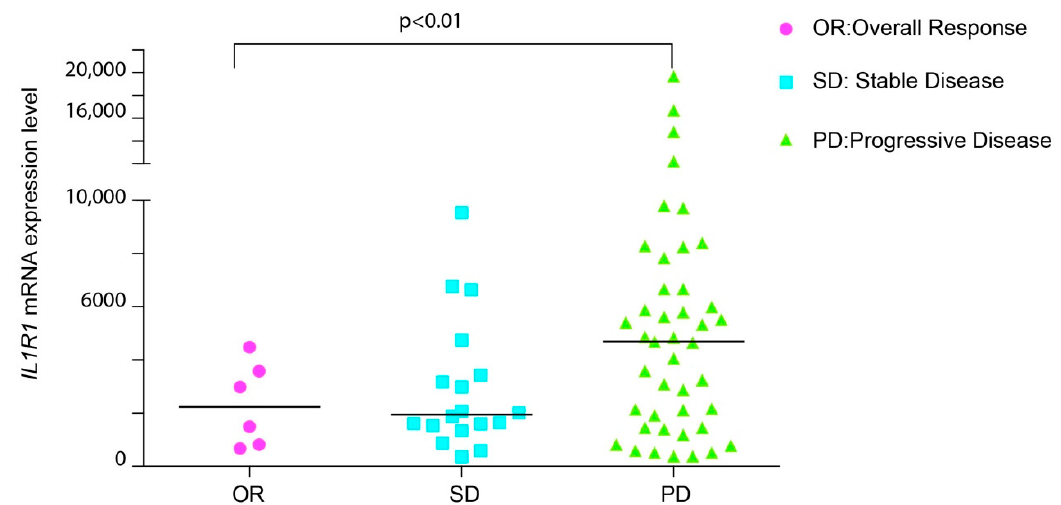
Figure 1. IL-1R1 abundance predicts response to CTX in patients . Expression analysis of IL-1 receptor in 67 CRC patients treated with CTX. Responsive patients (OR) as well as stable disease (SD) display low amounts of IL-1R1 compared to the non-responsive patients (PD). The differences in IL-1R1 expression between individual groups (OR/SD/PD) were determined by one-way analysis of variance (ANOVA), followed by Fisher LSD